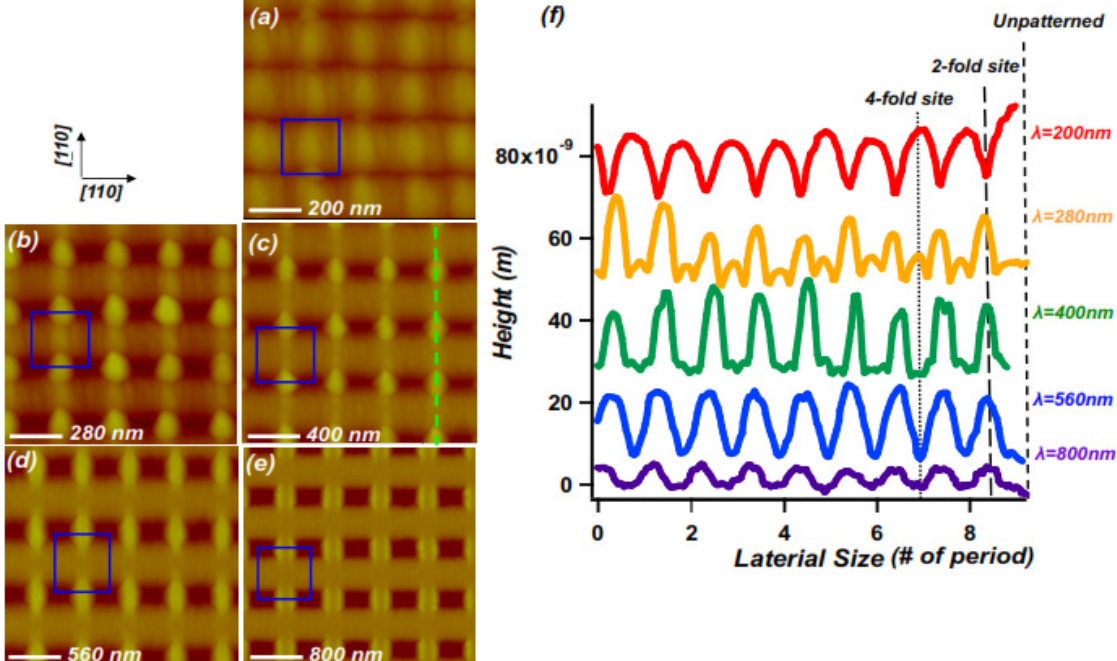
Figure 3. AFM images of nanopatterned GaAs (001) topography after homoepitaxial growth of 100 nm layer on nanopit arrays with different center to center spacings, λ ; ( f ) Measured height profiles from Figure 3 a – e , taken along (cid:4670)1(cid:3364)10(cid:4671) , across bridge sites, as shown by green dashed line in ( c ); profiles are offset vertically for visibility; the horizontal axes are each normalized to the individual λ . Growth conditions as in Figure 1, i . e ., growth temperature = 460 °C; growth rate = 0.28